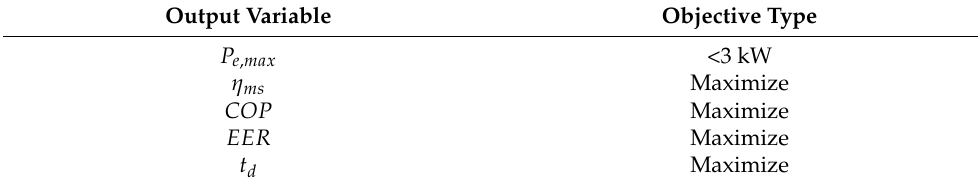
Table 3. Output variables and optimization choices in the